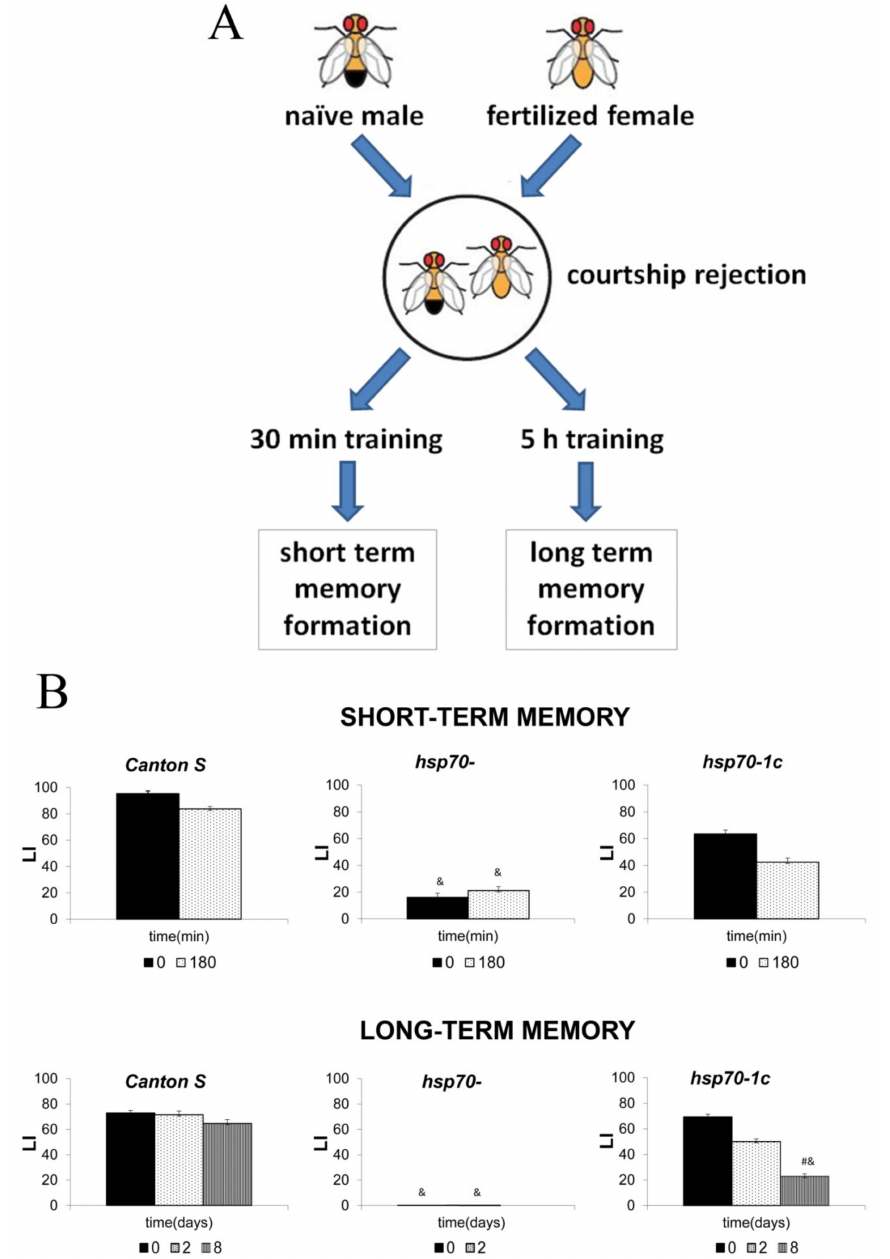
Figure 3. Results of an experiment on the effect of Hsp70 on memory. ( A ) A fertilized Drosophila female rejects the male’s advances by spraying him with an anti-aphrodisiac secretion. The male, who remembers the reaction of the fertilized female, later refuses to court fertilized females. ( B ) STM and LTM in males of the Canton S strain with six copies of the Hsp70 gene, the Hsp70-knockout strain (Hsp70-), and the strain with one restored copy of the Hsp70 gene (Hsp70-1c). The absence of Hsp70 led to a decrease in STM and loss of LTM, whereas restoring a single copy of Hsp70 restored STM and LTM, compared to the corresponding memory levels in the Hsp70-negative strain. LI refers to learning index. &, #— p < 0.05.